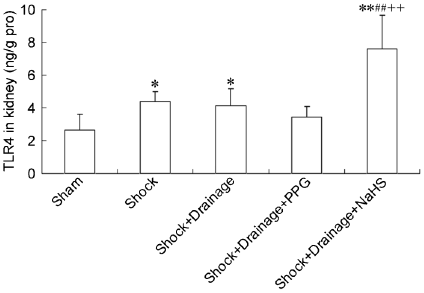
Figure 7. Changes in tumor necrosis factor (TNF)- a levels in the renal homogenates of rats. Data are reported as means±SD (ng/g protein, n=6). PPG: D,L-propargylglycine; NaHS: sodium hydro- sulfide hydrate. **P , 0.01 vs the sham group; # P , 0.05, ## P , 0.01 vs the shock group; + P , 0.05, ++ P , 0.01 vs the shock++drainage group (one-way